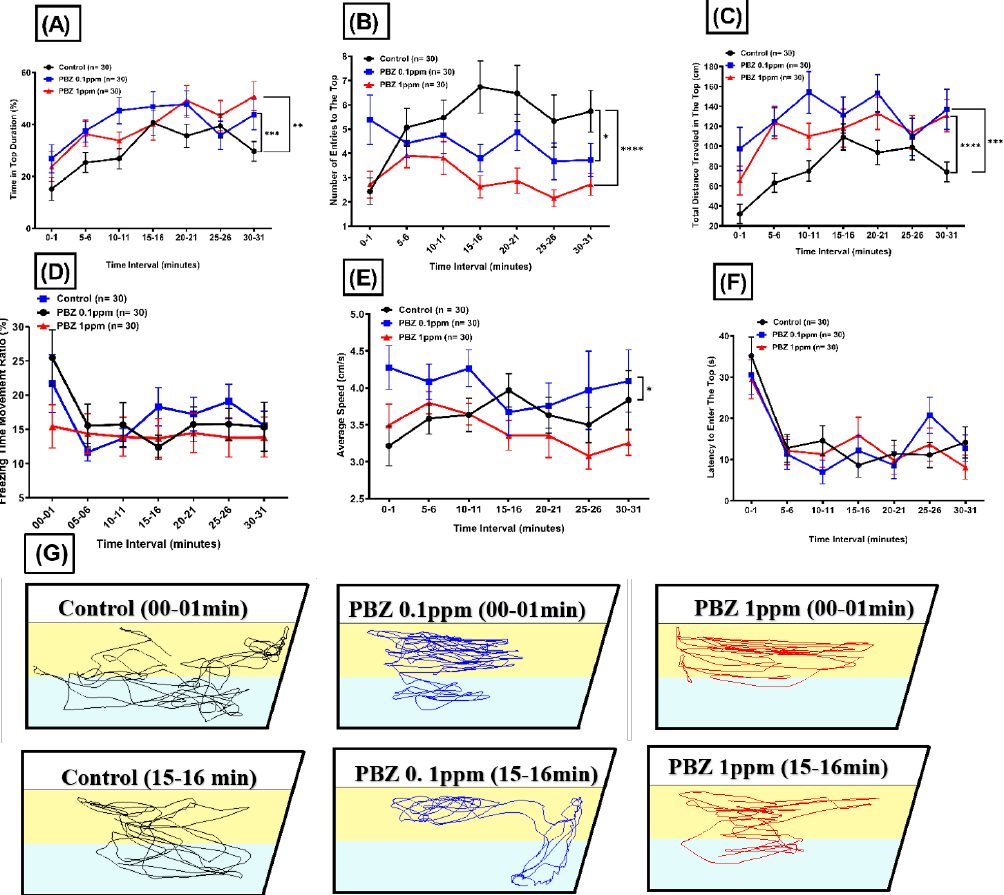
Figure 5. Novel tank exploratory behavior test for adult zebrafish after exposed to different doses of Paclobutrazol. The measured behavioral endpoints including: ( A ) time in top duration, ( B ) average speed, ( C ) freezing time, ( D ) number of entries in the top, ( E ) latency to enter in the top, and ( F ) total distance travel in the top. ( G ) Trajectories of adult zebrafish in novel tank assay after exposed to 0 (control), 100 µg/L (0.1 ppm), and 1000 µg/L (1 ppm) of Paclobutrazol (PBZ). The data are expressed as the means ± S.E.M. and were analyzed by the one-way ANOVA (* p < 0.05, ** p < 0.01, *** p < 0.001, **** p < 0.0001).